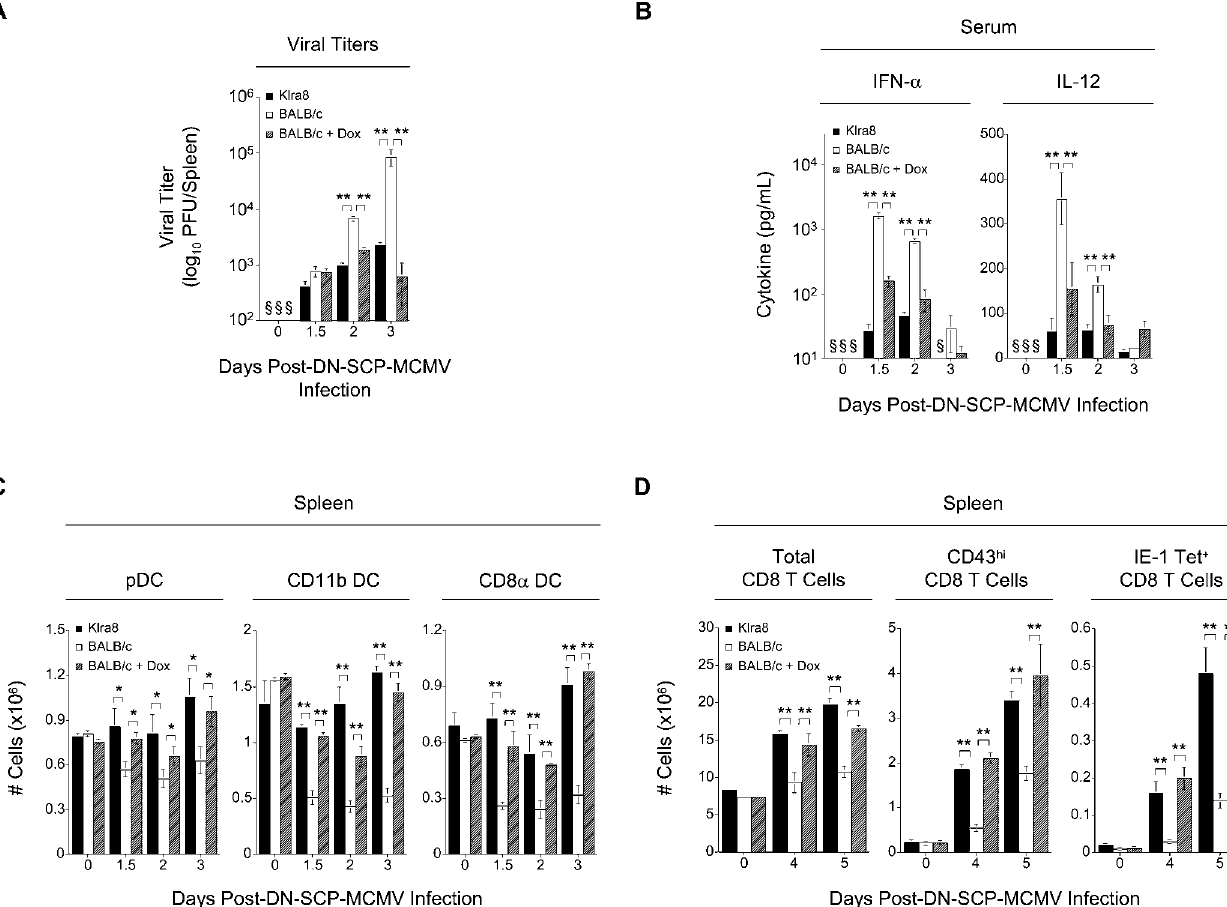
Figure 7. Control of Early Viral Load Results in Decreased pDC Cytokine Production, the Maintenance of cDCs, and the Accelerated Expansion of Antigen-Specific CD8 T Cells (A) Spleens from Klra8, BALB/c, and BALB/c mice treated with doxycycline 20 h post-infection were harvested on days 0, 1.5, 2, and 3 post–DN-SCP- MCMV infection and homogenized. Viral titers were determined and are presented as in Figure S1B. (B) Serum from Klra8, BALB/c, and BALB/c mice treated with doxycycline 20 h post-infection was collected on days 0, 1.5, 2, and 3 post–DN-SCP-MCMV infection. Cytokine levels of IFN- a and IL-12p70 were determined and are presented as in Figure 1. (C) Splenic leukocytes were isolated from on days 0, 1.5, 2, and 3 post–DN-SCP-MCMV infection from Klra8, BALB/c, and BALB/c mice treated with doxycycline 20 h post-infection. The total numbers (in millions) of pDCs, CD11b cDCs, and CD8 a cDCs were determined and are presented as in Figure 2. (D) Splenic leukocytes were isolated on days 0, 4, and 5 post–DN-SCP-MCMV infection from Klra8, BALB/c, and BALB/c mice treated with doxycycline 20 h post-infection. Total numbers (in millions) of CD8 T cells, CD43 hi CD8 T cells, and IE-1 tetramer þ CD8 T cells were determined and are presented as in Figure 3. One experiment representative of two for (A–C), and four for (D) are shown. * p (cid:3) 0.05; ** p (cid:3) 0.01; § ¼ not detected.